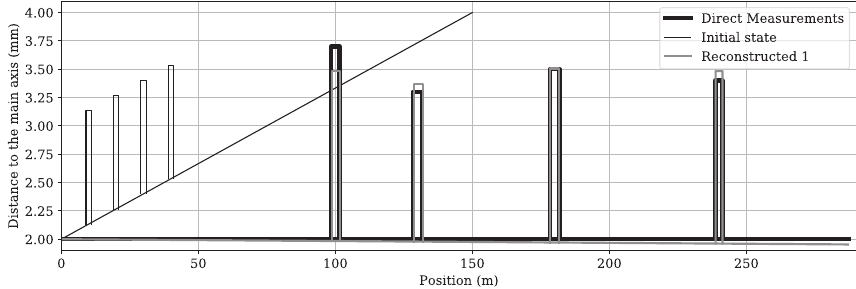
Figure 9. Comparison between the geometry obtained by direct measurement (wide black line), the initial state (thin black line) and the reconstructed geometry from the fi rst set of data (grey). For readability the vertical and horizontal axis have different